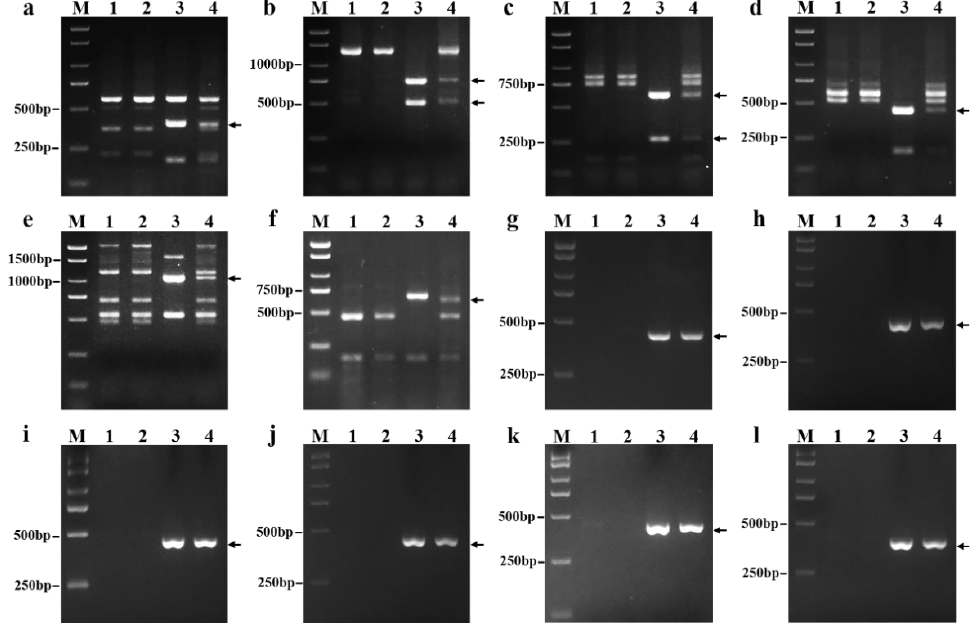
Figure 3. PCR amplification patterns of wheat PLUG and P. huashanica 7Ns chromosome-specific markers. ( a ) TNAC1782-TaqI ; ( b ) TNAC1803-HaeIII ; ( c ) TNAC1815-TaqI ; ( d ) TNAC1867-HaeIII ; ( e ) TNAC1806-TaqI ; ( f ) TNAC1845-TaqI ; ( g ) PH7Ns-9; ( h ) PH7Ns-14; ( i ) PH7Ns-38; ( j ) PH7Ns-43; ( k ) PH7Ns-48; and ( l ) PH7Ns-49. (M) Marker (2000 bp); (1) CS; (2) CS ph2b ; (3) P. huashanica ; and (4) 18- 1-5 (wheat – P. huashanica 7Ns disomic addition line). Arrows indicate the diagnostic amplification products for Ns genome.